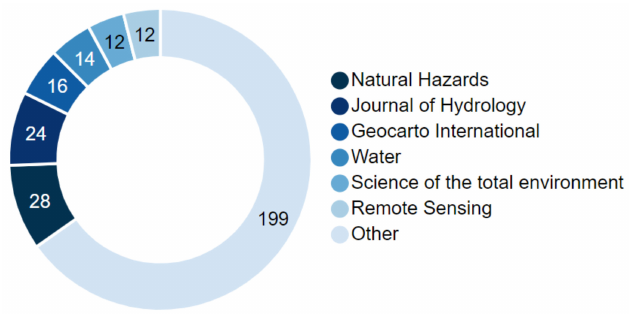
Figure 5. Top six journals.